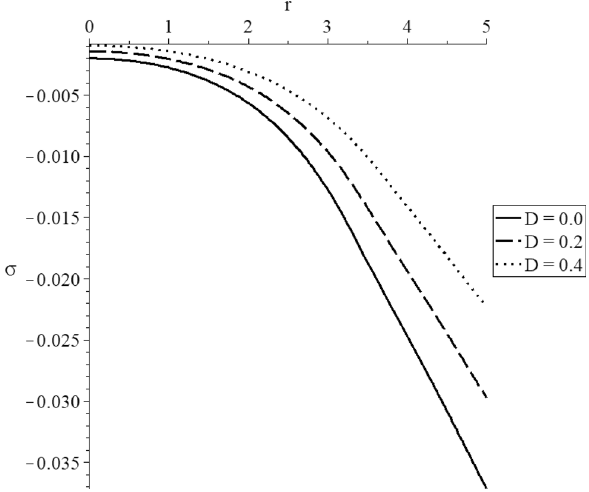
Figure 13. The average stress distribution with various values of the mechanical damage parameter.